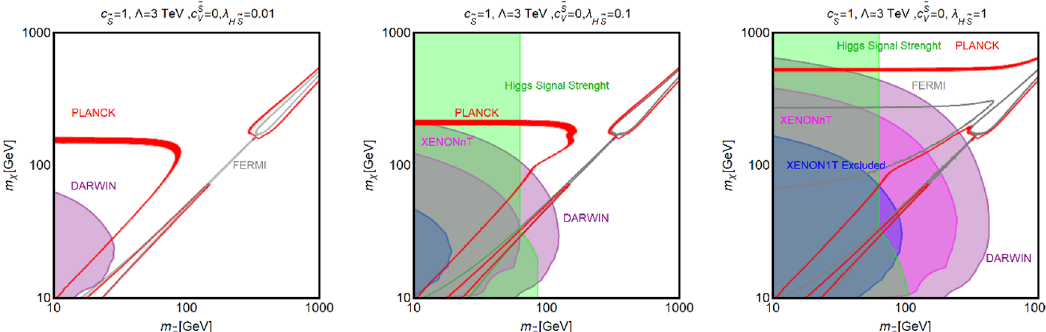
Figure 14 . Constraints in the m ~ (cid:0) m (cid:31) plane for the Yukawa portal with c ~ = 1 ; y ~ = 1 and three S S S di(cid:11)erent assignations of (cid:21) ~ = 0 : 01 ; 0 : 1 ; 1. The isocontours of correct relic density are shown in HS red while the current (projected) limits from XENON1T (XENONnT/DARWIN) are given in blue (magneta/purple). The gray isocontours indicate limits from DM ID (viable regions of parameter space are outside these contours), while bounds from the h ! ~ S ~ S decay are shown in green. c ~ and y ~ to 1 and varying instead the coupling (cid:21) from 0.01 to 1. As can be S S H ~ S